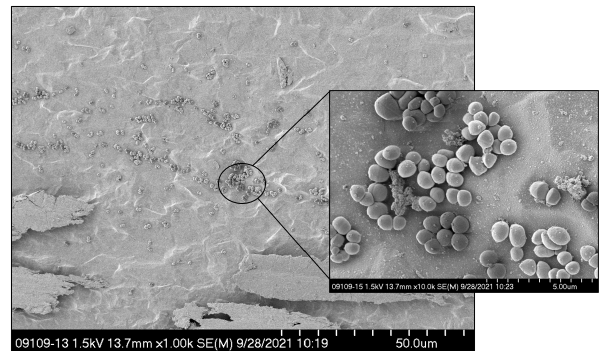
Figure 1. Scanning electron microscopy of the MRSA-seeded im-